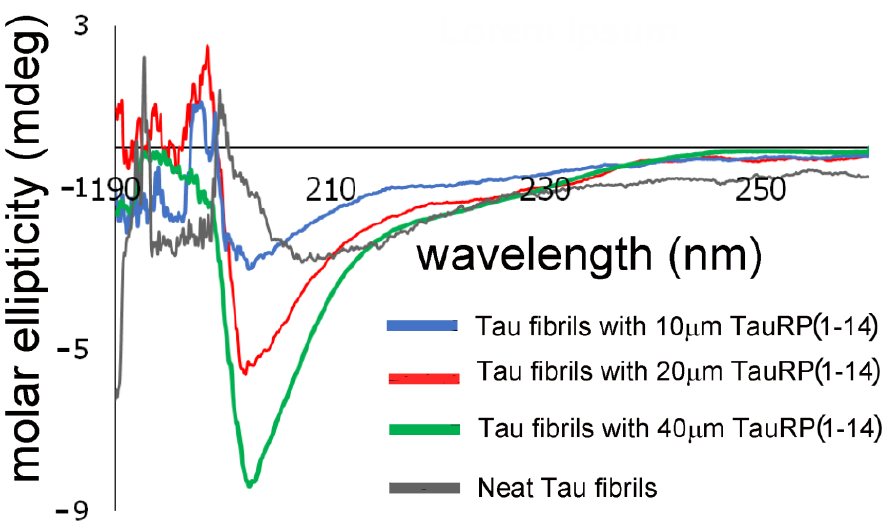
Figure 9. Comparison of far UV CD spectra recorded for Tau fibrils before and after association with varying concentrations of TauRP (1 – 14).